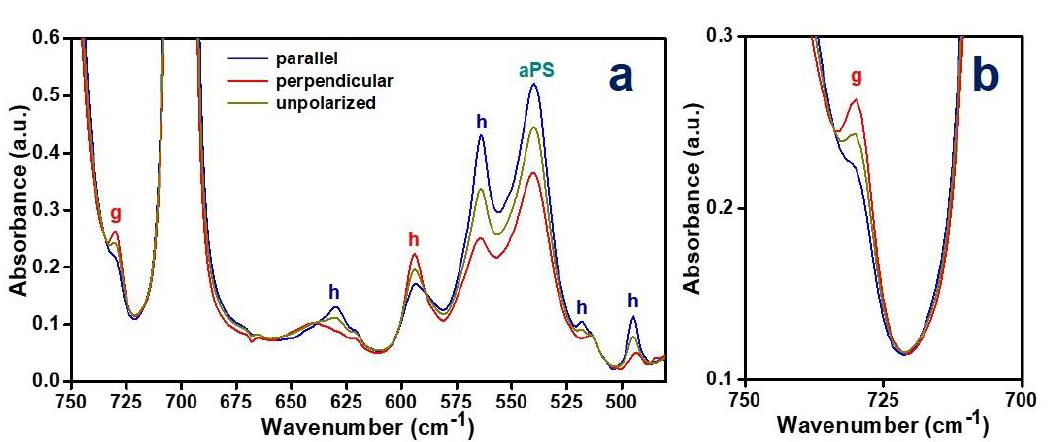
Figure 4. Polarized FTIR spectra of a PPO/aPS blend film exhibiting a CC PPO/toluene phase, after stretching at 175° up to a draw ratio of 3, as collected with the polarization plane parallel (blue lines) or perpendicular (red lines) to the film stretching direction: ( a ) 750–480 cm −1 ; ( b ) 750–700 cm −1 . The unpolarized FTIR spectrum is shown as a grey line. Labels ( h ) and ( g ) indicate peaks of host PPO crystalline chains and of toluene guest, respectively.